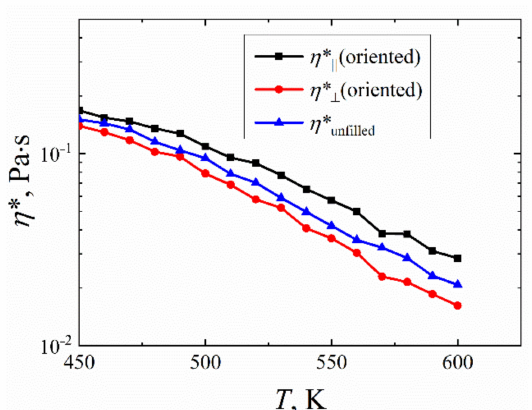
Figure 4. Temperature dependence of the complex viscosity η ∗ of R-BAPB samples oriented by SWCNT. The data calculated along η ∗ || (the results averaged for η ∗ calculated in XZ and YZ shear directions) and perpendicular η ∗ ⊥ ( η ∗ calculated in XY shear direction) to the SWCNT axis. Additionally, data for the unfilled amorphous R-BAPB samples η ∗ unfilled (averaged over three di- rections of shear deformation) are presented. The rheological properties of the unfilled amorphous R-BAPB sample η ∗ unfilled were taken for comparison from our previous study [75]. The error bars are compared to the size of the symbols. The results were obtained by computer simulations using Equations (1) and